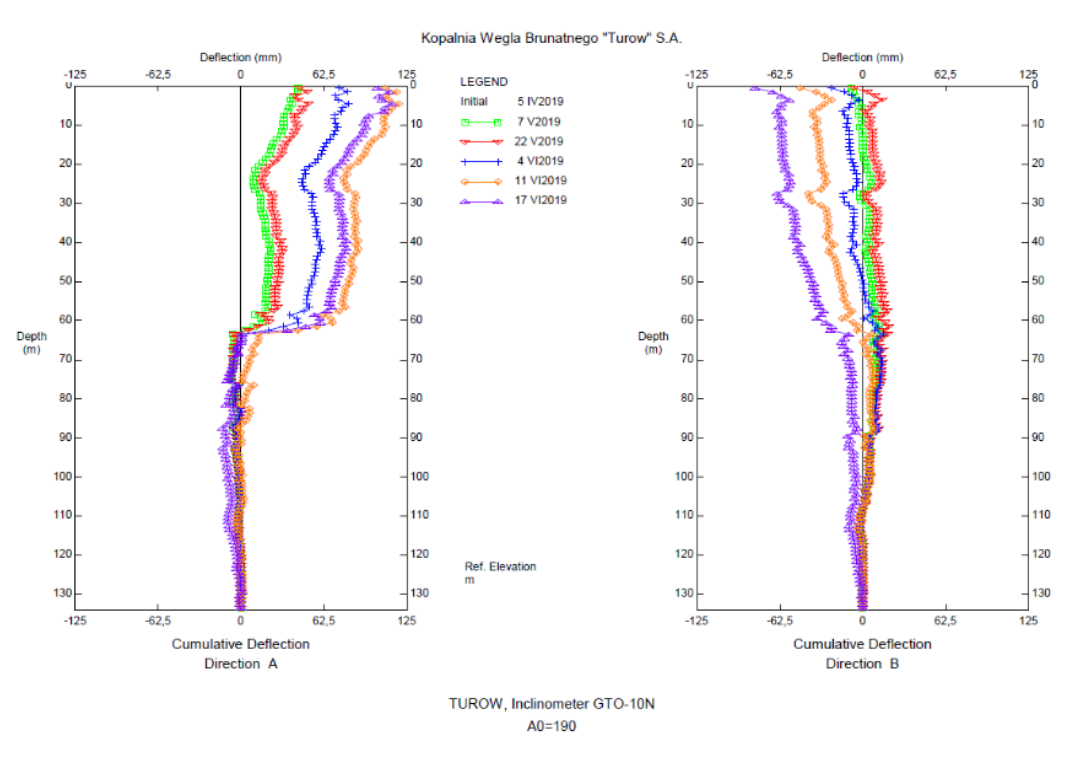
Figure 5: Subsurface displacements on inclinometer GTO-10.